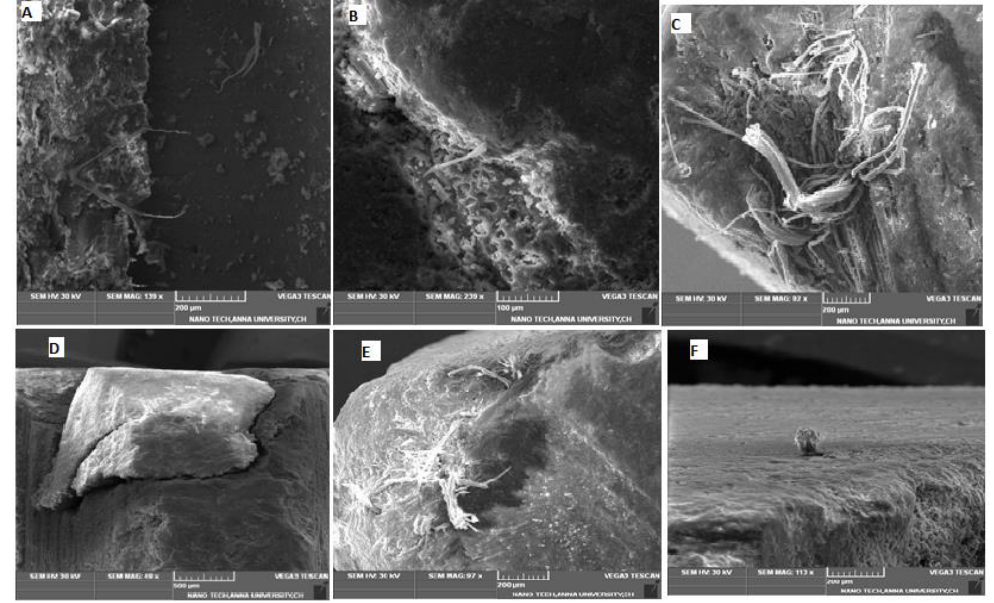
Figure 8. Fiber pull outs. ( A ) GFRPG-20. ( B ) FFRPG-20. ( C ) SFRPG-20. ( D ) Tooth break after 20 min of running in GFRPG-15. ( E ) FFRPG-15. ( F ) SFRPG-15.